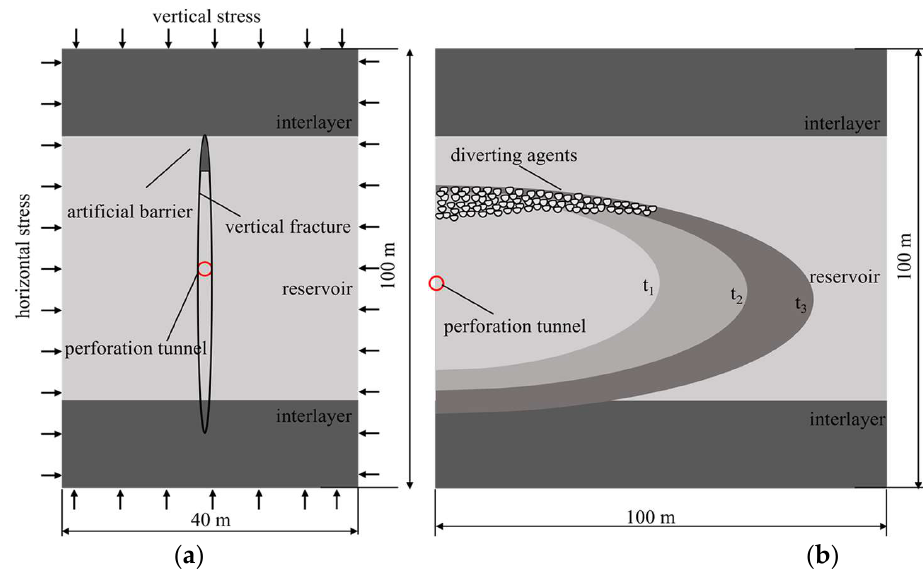
Figure 5. Three-dimensional numerical calculation model.